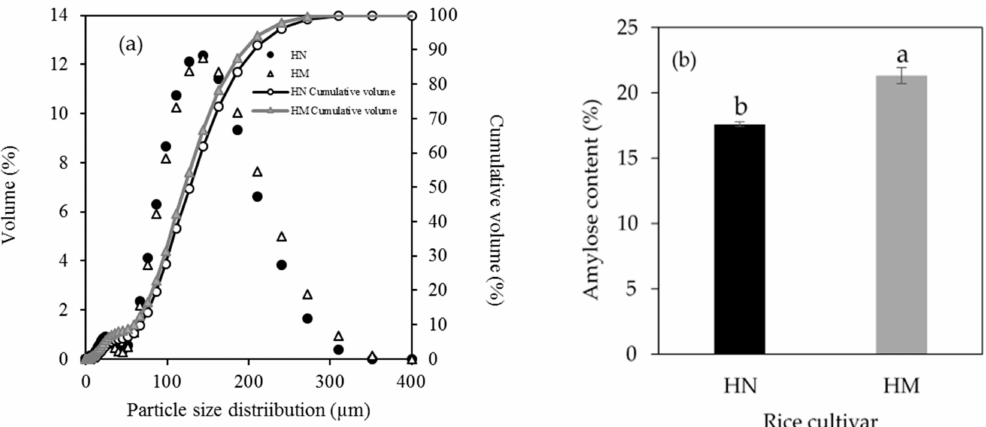
Figure 2. Particle size distribution ( a ) and amylose content ( b ) of Hom Nil rice flour (HN) and Hom Mali 105 rice flour (HM). The results are expressed as mean ± standard error of the mean (SEM), n = 3. The different letters denote statistically significant differences in mean values ( p < 0.01).